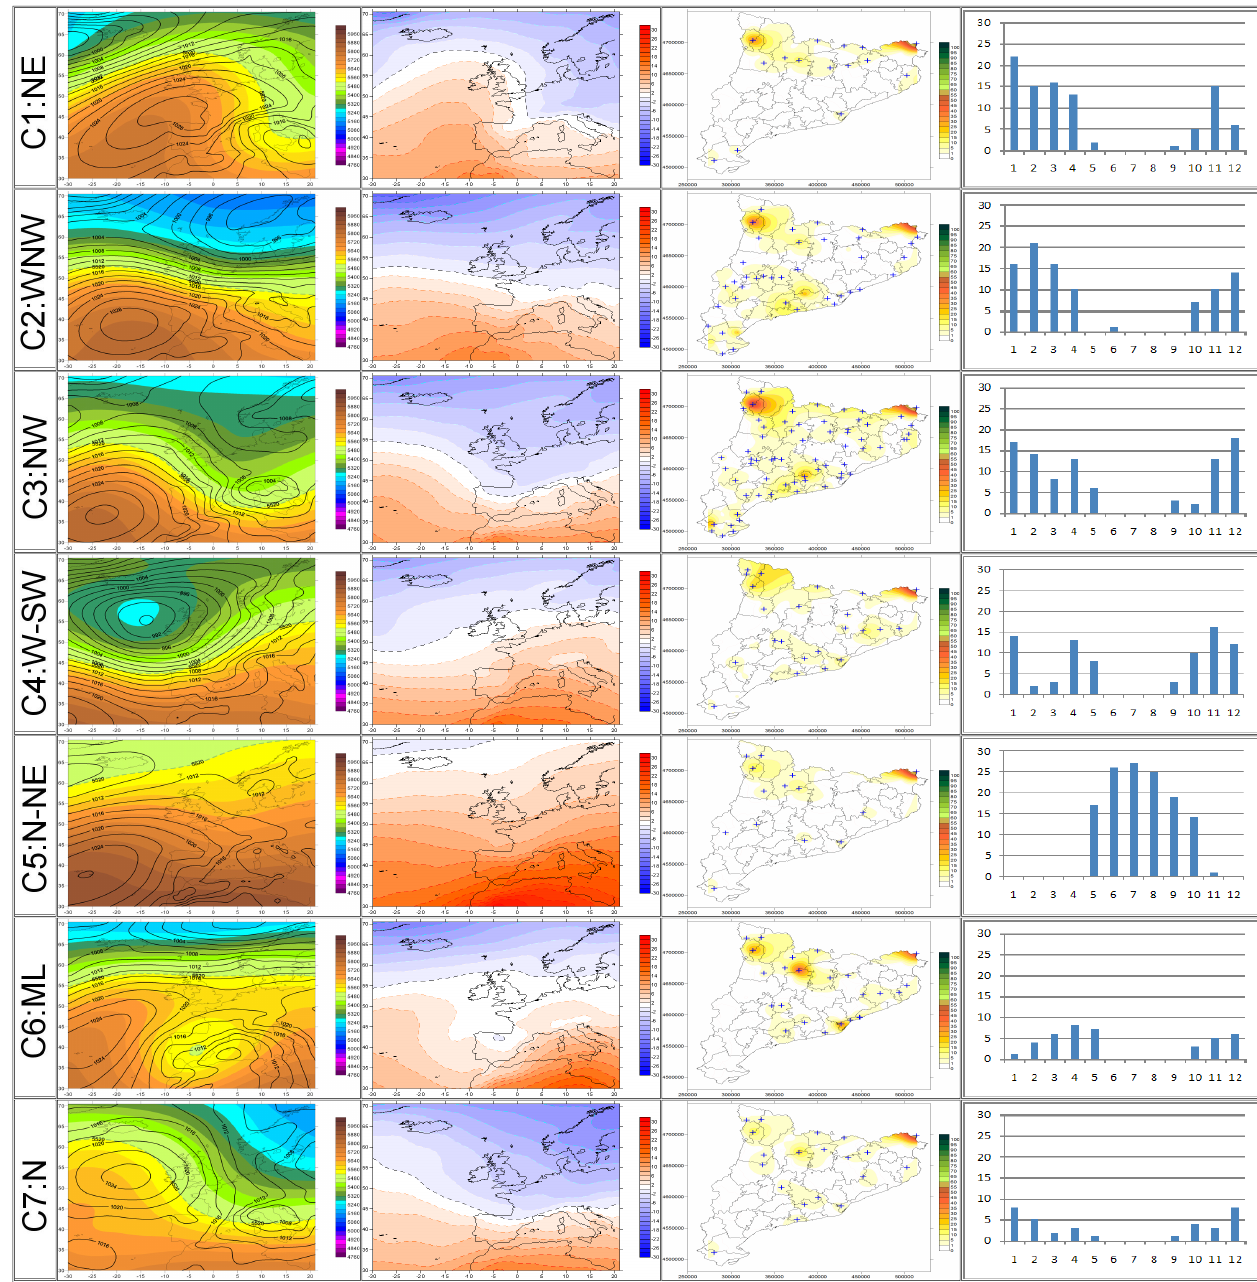
Fig. 6. Mean values of ERA-Interim reanalysis for each cluster (see acronym in Sect. 4.4). First column, geopotential at 500hPa in mgp (shaded) and mean sea level pressure in hPa (solid lines). Second column, temperature at 850hPa in ◦ C (shaded).Third column, % of strong wind days with respect to the total number of days in the cluster. Fourth column, monthly distribution of the number of strong wind